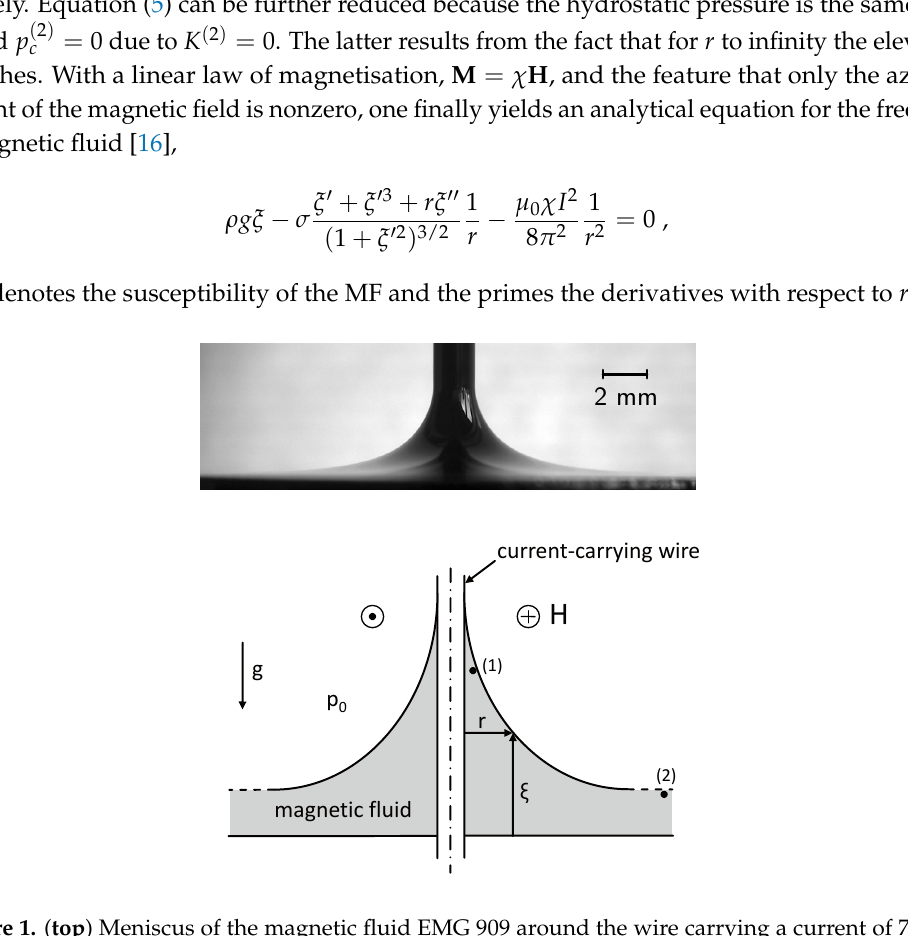
Figure 1. ( top ) Meniscus of the magnetic fluid EMG 909 around the wire carrying a current of 70 A. Courtesy of K. May [17]. ( bottom ) Sketch of the set-up (for details see